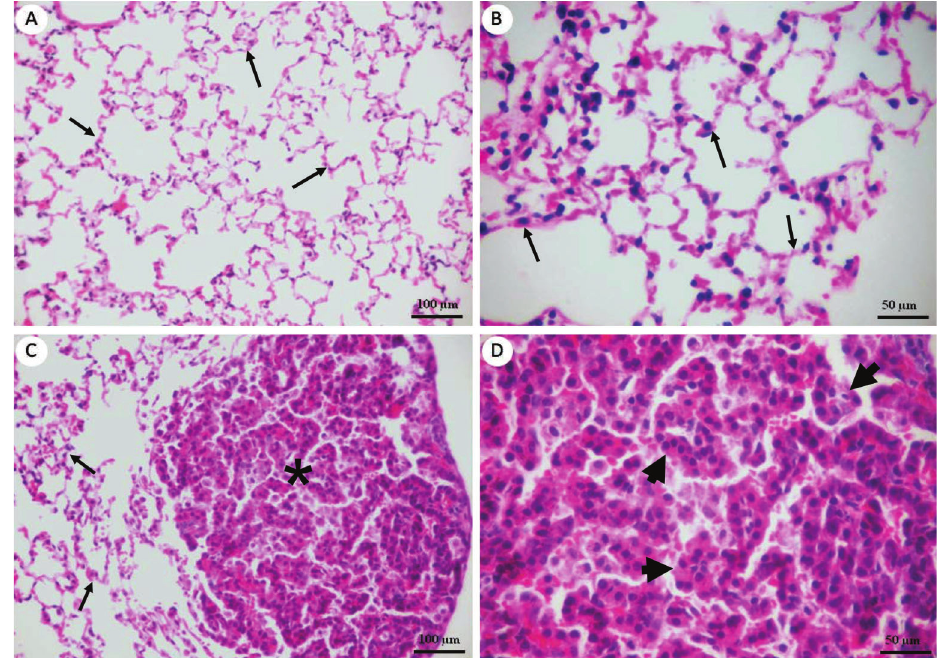
Figure 1. Histopathology of lung tissue. A and B , Preserved alveolar acini with delicate alveolar walls (arrows) in control mice (H&E). C and D , Lung tissue of urethane-injected mice showing atypical epithelial nodules (asterisk) with subpleural localization composed of round or oval cells (arrowheads) containing abundant eosinophilic cytoplasm and hyperchromatic nuclei, but without evident nucleoli, forming characteristic glands or acini (H&E).